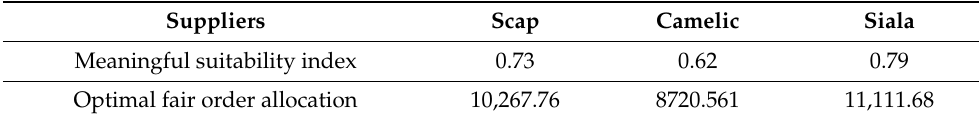
Table 10. The Final Result with the Cutoff